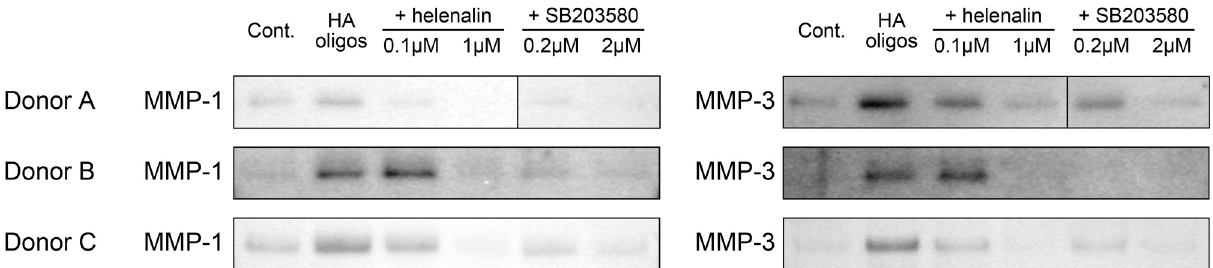
Fig 5. Effects of chemical inhibitors on MMP production induced by HAoligo treatment. After pretreatment with helenalin or SB203580 for one hour at the indicated concentrations, RSFs were stimulated with 250 μ g/ml HAoligos for 24 hours in the presence or absence of each inhibitor. The conditioned media was analyzed by immunoblot using antibodies against MMP-1 and MMP-3. The amount of sample separated by SDS-PAGE before transfer and immunostaining was determined by the DNA content of RSFs in each well. RSFs derived from three patients with RA were used. In donor A, SB203580 lanes were not adjacent to helenalin lanes. Thus, for clarity, SB203580 lanes were cut out and displayed next to helenalin lanes.